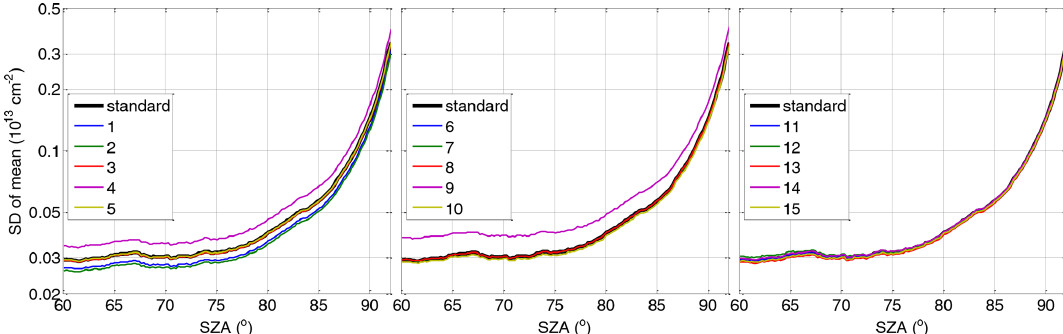
Figure B2. Standard deviation of the binned mean OClO SCD for 25 December 2018 in the NH for the different cases of the sensitivity study described in Table 2 in comparison with the standard scenario for selected days in both hemispheres.